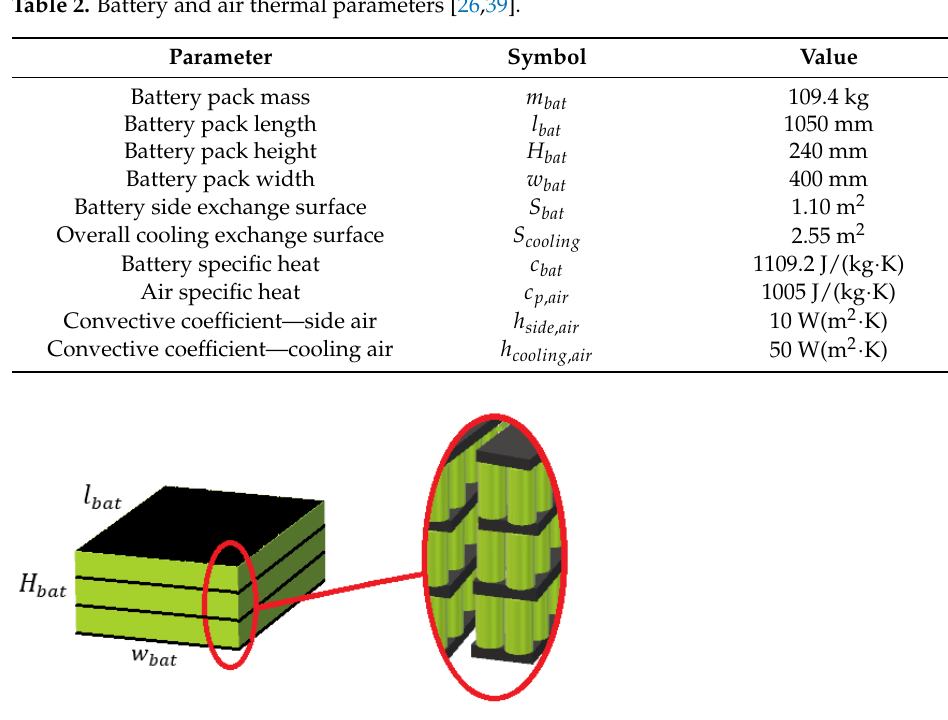
Table 2. Battery and air thermal parameters [26,39].